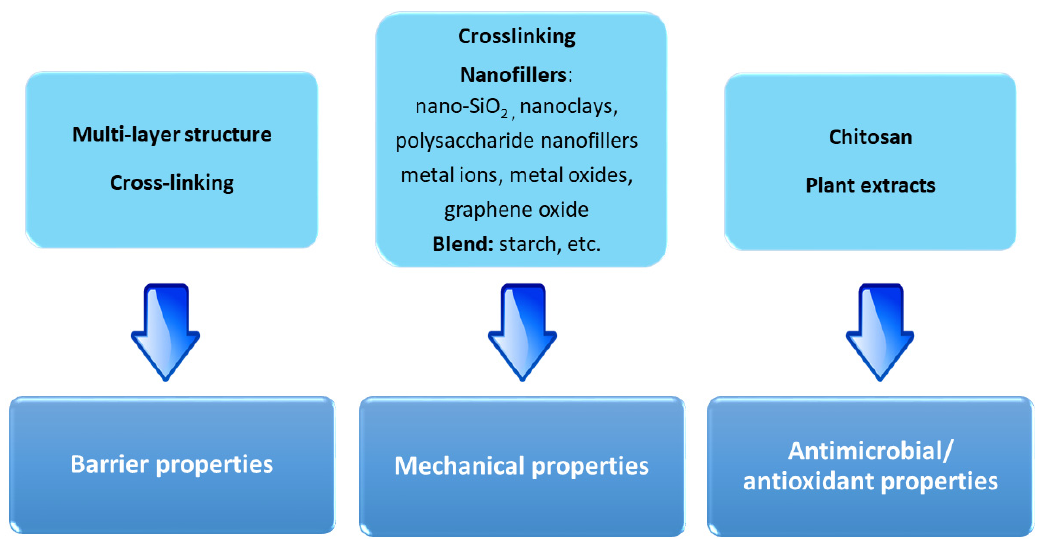
Figure 7. Strategies for improving the performance of fish gelatin and/or chitosan films for food packaging.